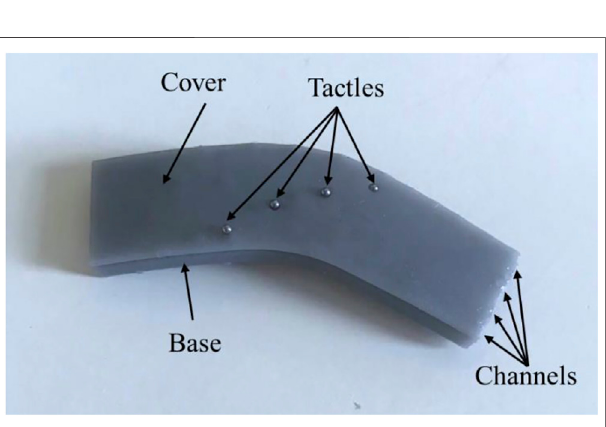
FIGURE 6 | Encapsulated sensor for a 3D